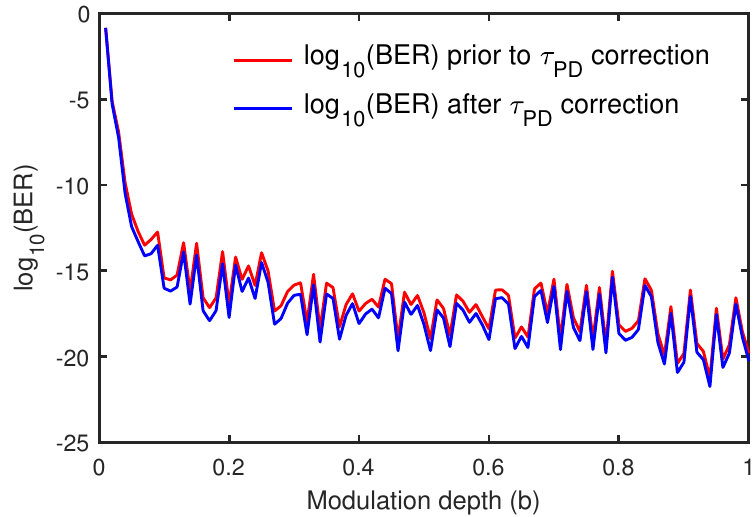
Figure 12. Estimation of BER values of the recovered messages as a function of a modulation depth for BR = 1.2Gbit/s message signal. Red (blue) trace correspond to BER value prior to (after) the τ PD correction in the receiver